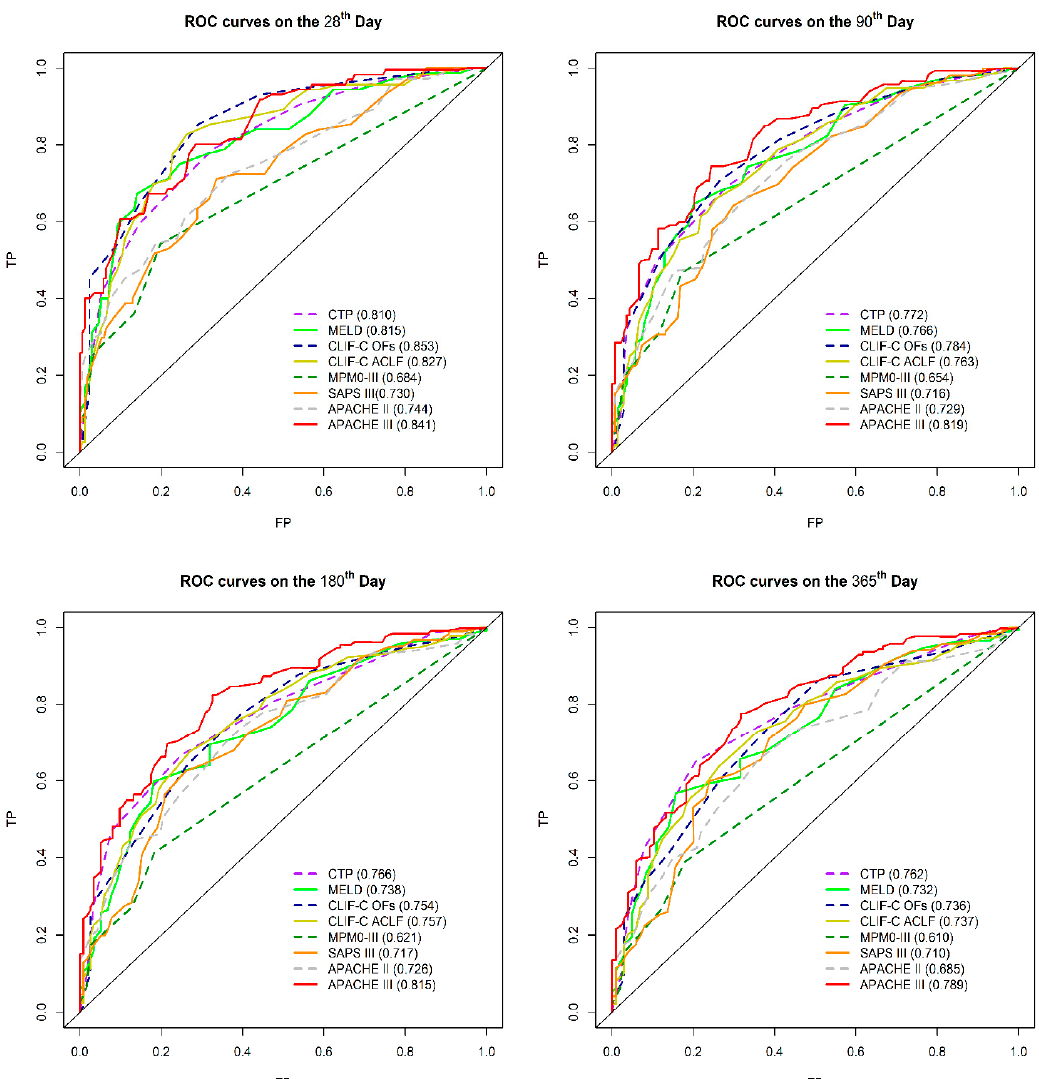
Figure 3. Comparison of prognostic scores to predict 28-day, 90-day, 180-day, and 365-day mortality by AUROC. Table 3. Comparison of the 8 prognostic scores to predict 28-day mortality by AUROC.